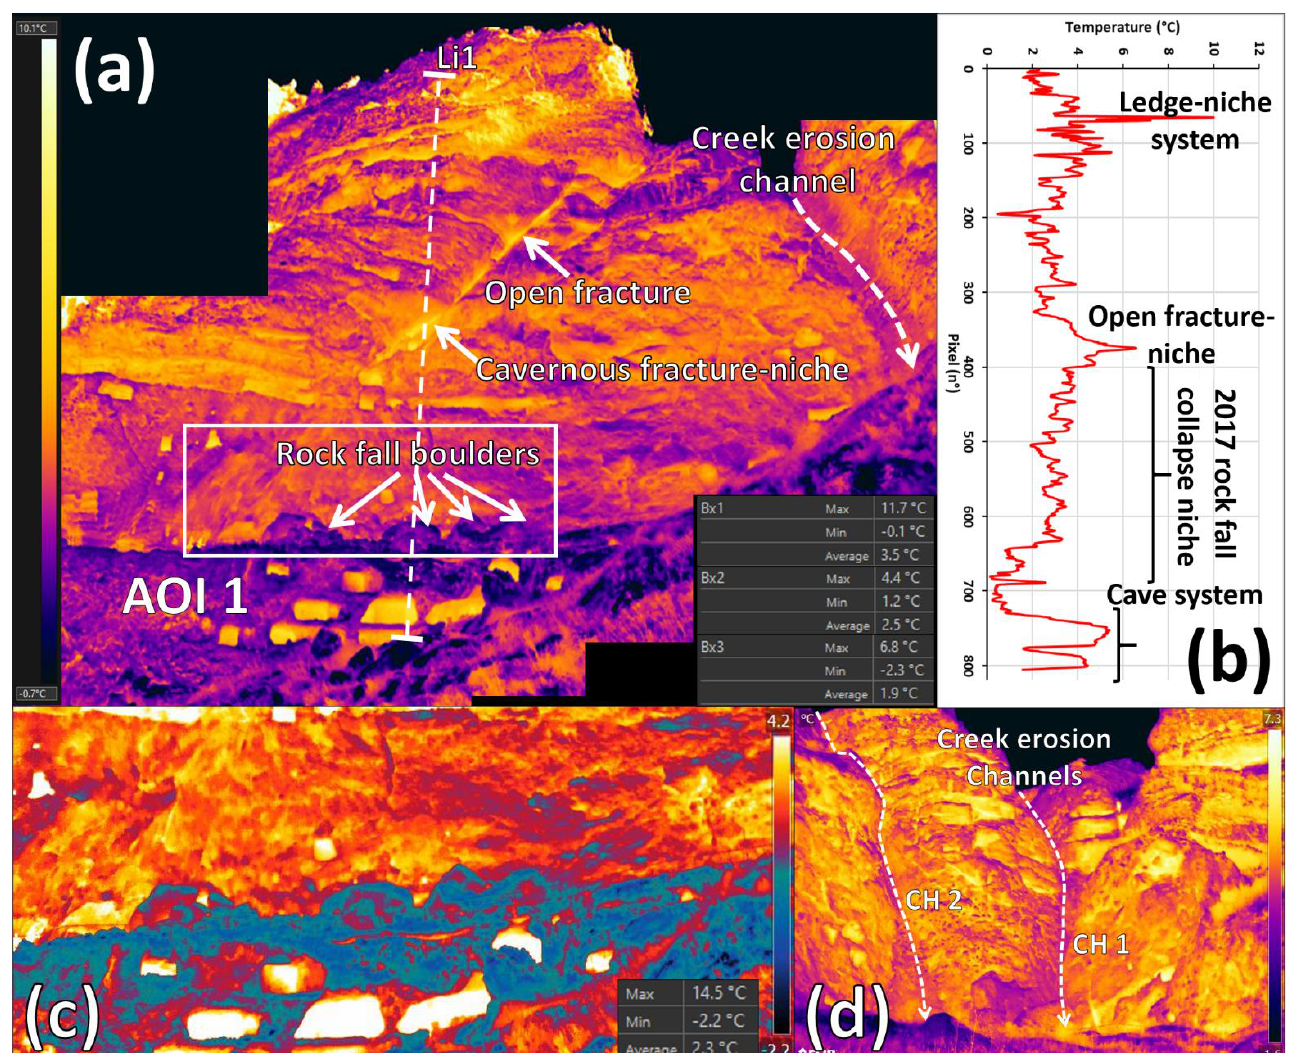
Figure 8. Vanis Kvabebi IRT data: mosaicked surface temperature map of the main sector of the eastern cliff ( a ) (the white rectangle represents the Area of Interest 1 = AOI 1 shown in ( c )); vertical surface temperature profile of the cliff ( b ) (Li1 in a ); detail of the 2017 collapse sector (AOI 1) ( c ); surface temperature map of the cliff’s southern sector ( d ).